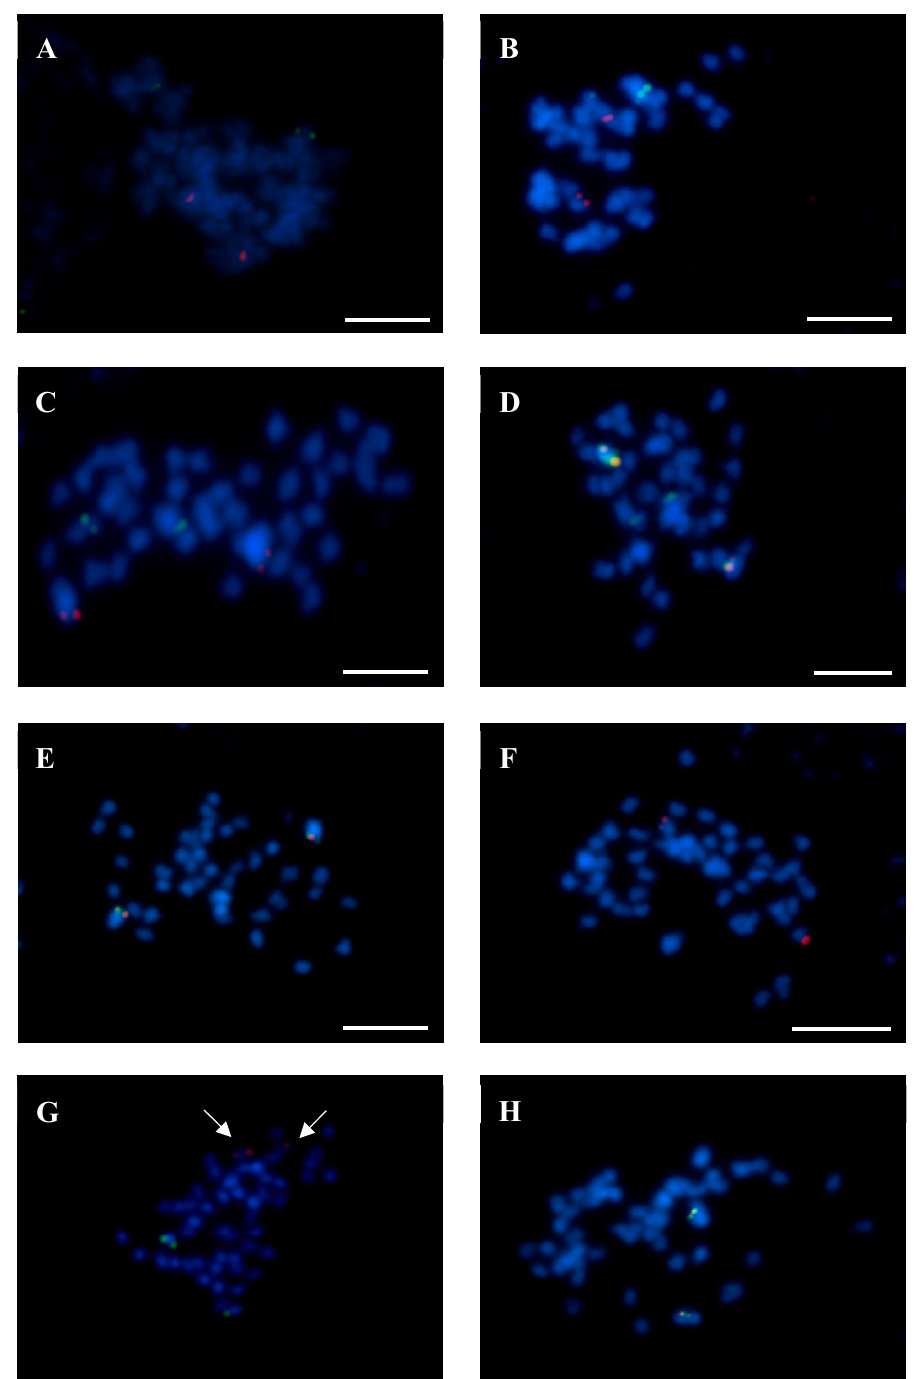
Figure 5. Localization of BAC clones from chromosome Lang06 in chromosomes of related lupins. ( A ) L. luteus— BAC 44J16 (red signals) and BAC 51D03 (green signals). ( B ) L. pilosus— BAC 80B11 (red) and BAC 76K16 (green). ( C ) L. pilosus— BAC 51D03 (red) and BAC 76K16 (green). ( D ) L. palaestinus— BAC 80B11 (red) and BAC 76K16 (green). ( E ) L. digitatus – BAC 80B11 (red) and BAC 76K16 (green). ( F ) L. hispanicus— BAC 80B11 (red). ( G ) L. micranthus – BAC 80B11 (red) and BAC 127N17 (green). (H) L. micranthus— BAC 51D03 (red) and BAC 127N17 (green). Chromosomes were stained with DAPI (blue). Arrows in (H) show the localization of BAC 80B11 (red). Scale bars, 5 µm.